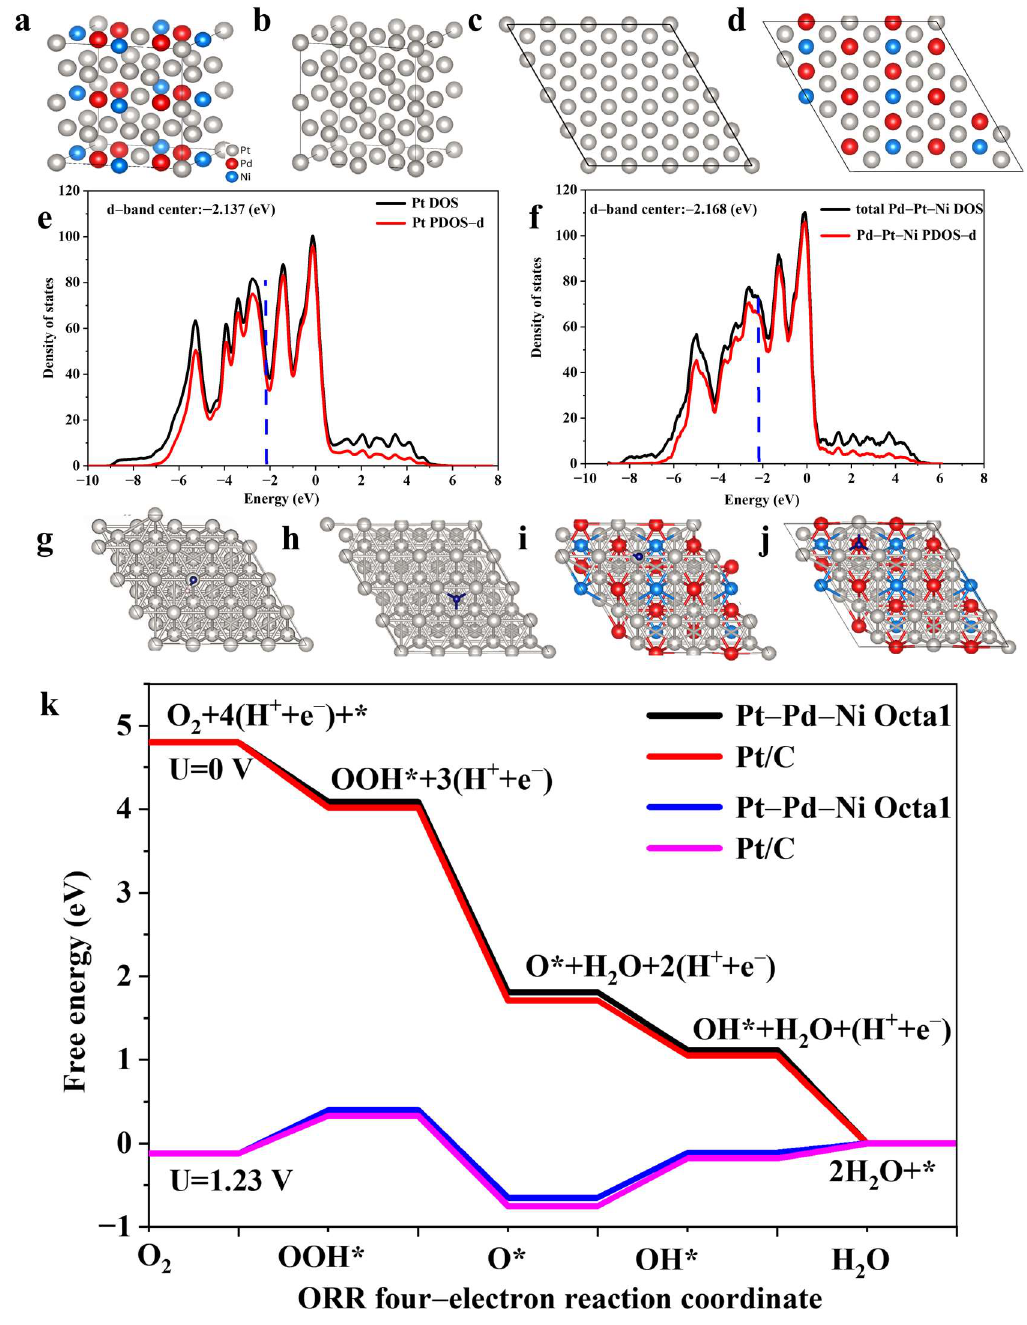
Figure 7. ( a ) Volume model diagram of the Pt/C catalyst; ( b ) volume model diagram of the Pt-Pd-Ni ternary nanocatalyst; ( c ) schematic diagram of the crystal plane of the Pt/C catalyst (111); ( d ) schematic diagram of the crystal plane structure of the Pt-Pd-Ni ternary nanocatalyst (111); ( e ) Pt/C state density diagram; ( f ) State density diagram of the Pt-Pd-Ni ternary nanocatalyst; ( g ) adsorption structure of the intermediate O* on the Pt (111) surface; ( h ) adsorption configuration of the intermediate OH* Pt (111) surface; ( i ) adsorption structure of the intermediate O* on the Pt-Pd-Ni Octa1 (111) surface; ( j ) adsorption configuration on the surface of the intermediate OH* Pt-Pd-Ni Octa1 (111); ( k ) Gibbs free energy changes at each step of the four-electron ORR. It was found that the distance between the Pt atoms and other atoms in the model of the Pd-Pt-Ni (111) surface on Pd-Pt-Ni Octa1 were significantly shorter than that of the Pt’s (111) surface (as shown in Table S2), which is consistent with the